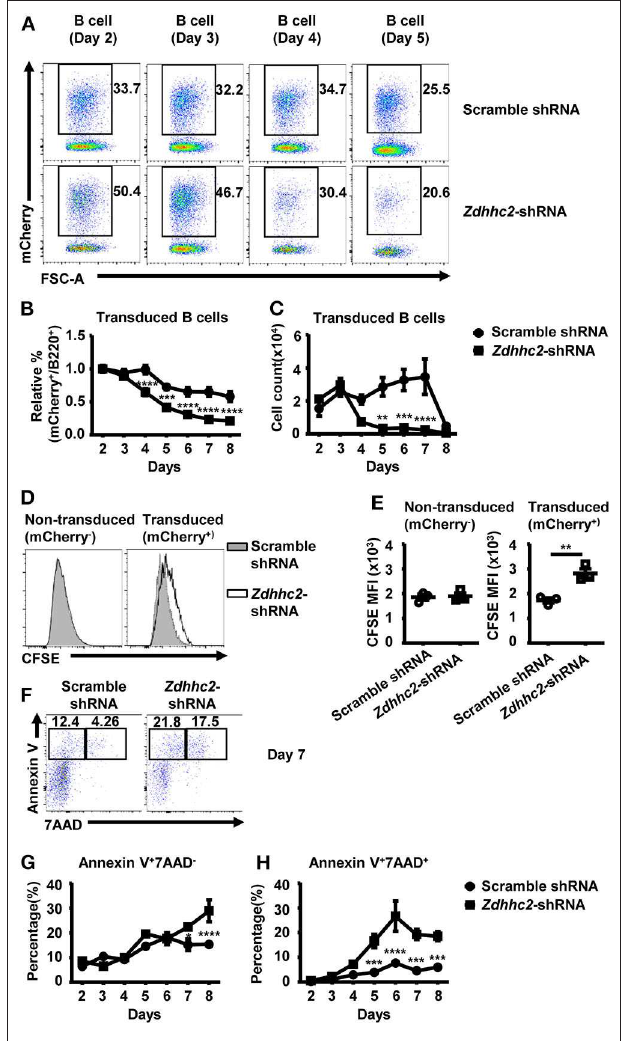
FIGURE 6 | The reduced proliferation and the increased cell death in Zdhhc2 -shRNA transduced B cells. (A) Representative flow cytometry profiles showing the percentages of scramble shRNA or Zdhhc2 -shRNA transduced cells (mCherry + ) among B cells (B220 + ) cultured as in Figure 4 on days 2–5. (B,C) Representative graphs showing the relative percentage (normalized to the values on day 2) (B) or the absolute number (C) of scramble shRNA or Zdhhc2 -shRNA transduced cells among B cells at the indicated time points in the culture described as in Figure 4 . (D,E) Representative flow cytometry profiles showing the carboxyfluorescein succinimidyl ester (CFSE) levels (D) and graphs showing the CFSE MFI levels (E) in scramble shRNA or Zdhhc2 -shRNA transduced B cells (mCherry + ) and non-transduced B cells (mCherry − ). The splenic cells were cultured and transduced as described in Figure 4A on day − 1 and day 0, then labeled with CFSE on day 2 and further co-cultured with irradiated NB-21.2D9 feeder cells, and analyzed for CFSE levels on day 4. (F,G,H) Representative flow cytometry profiles (F) and graphs showing the percentages of apoptotic cells (Annexin-V + 7AAD − ) (G) and dead cells (Annexin-V + 7AAD + ) (H) in scramble shRNA or Zdhhc2 -shRNA transduced B cells (mCherry + ). Each symbol represents an independent culture. The bars represent mean ± SEM. * p ≤ 0.05, ** p ≤ 0.01, *** p ≤ 0.001, **** p ≤ 0.0001, two-way ANOVA with Sidak’s multiple-comparisons test (B,C,G,H) or unpaired two-tailed t -test (E) . The data are representative of two independent